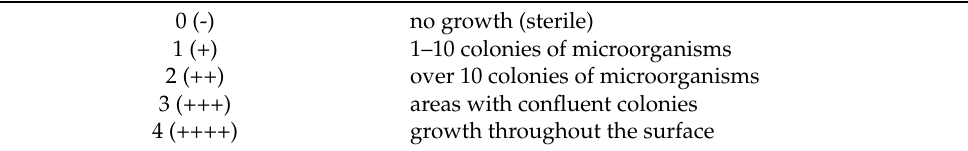
Table 2. Quantification of the biological load according to STAS